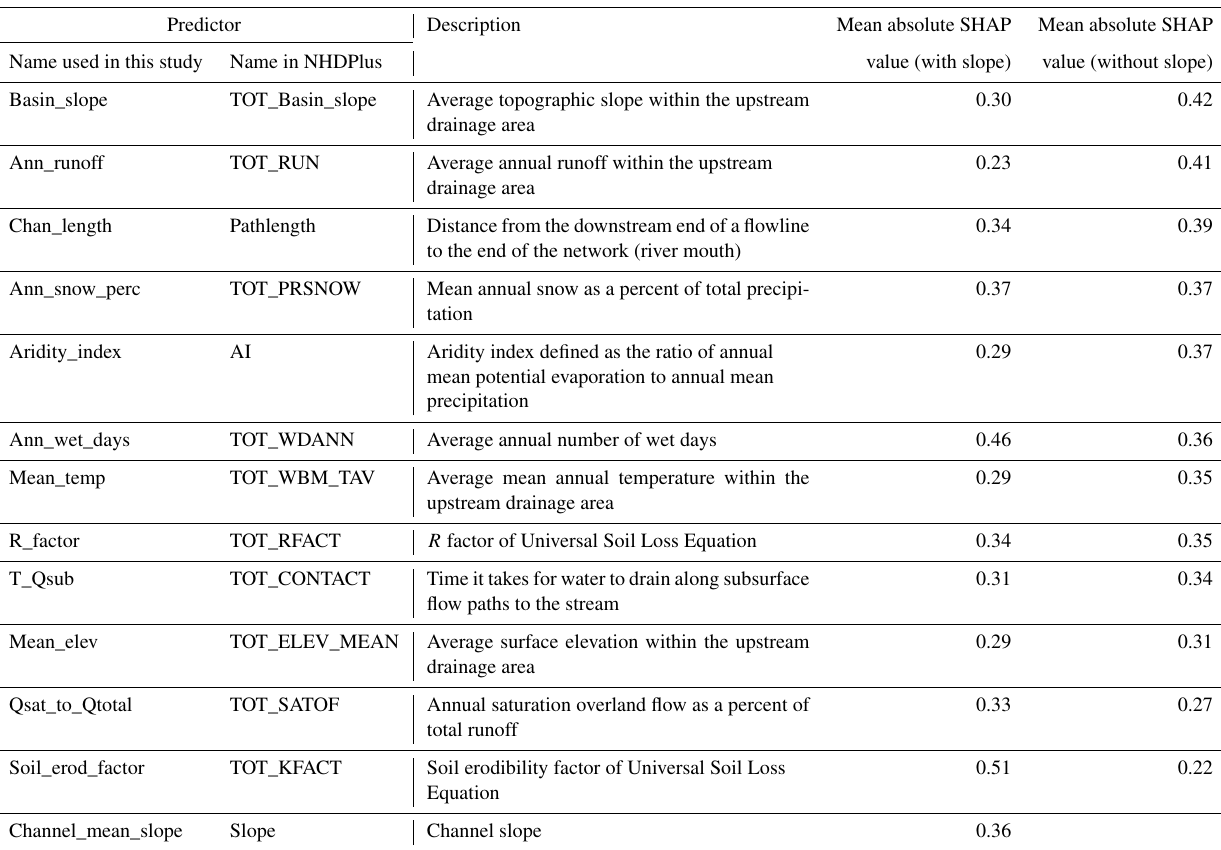
Table 1. Most important predictors according to the feature selection. Predictor